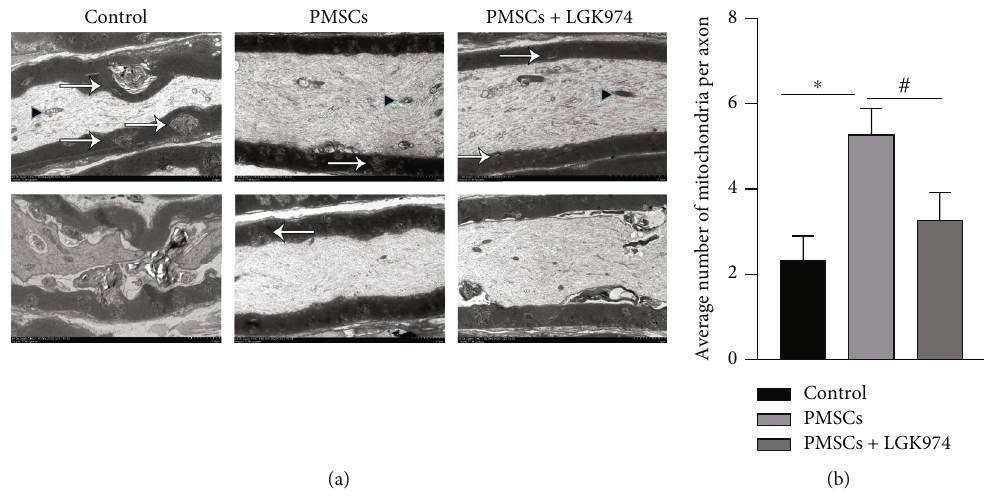
Figure 7: After transplantation, the structure of sciatic nerve was observed under electron microscope at 28 days. (a) There were more mitochondria in the PMSC group than those in the control group and PMSC+LGK974 group ( P < 0 : 05 ). The myelin sheath of the PMSC group was more complete. Black triangles indicate mitochondria, and white arrows indicate lesions. (b) Number of mitochondria per axon. Data were mean ± SEM . n = 3 independent experiment; ∗ PMSC group vs. control group, P < 0 : 05 ; # PMSC group vs. PMSC +LGK974 group, P < 0 : 05 . The scale bar: 2 μ